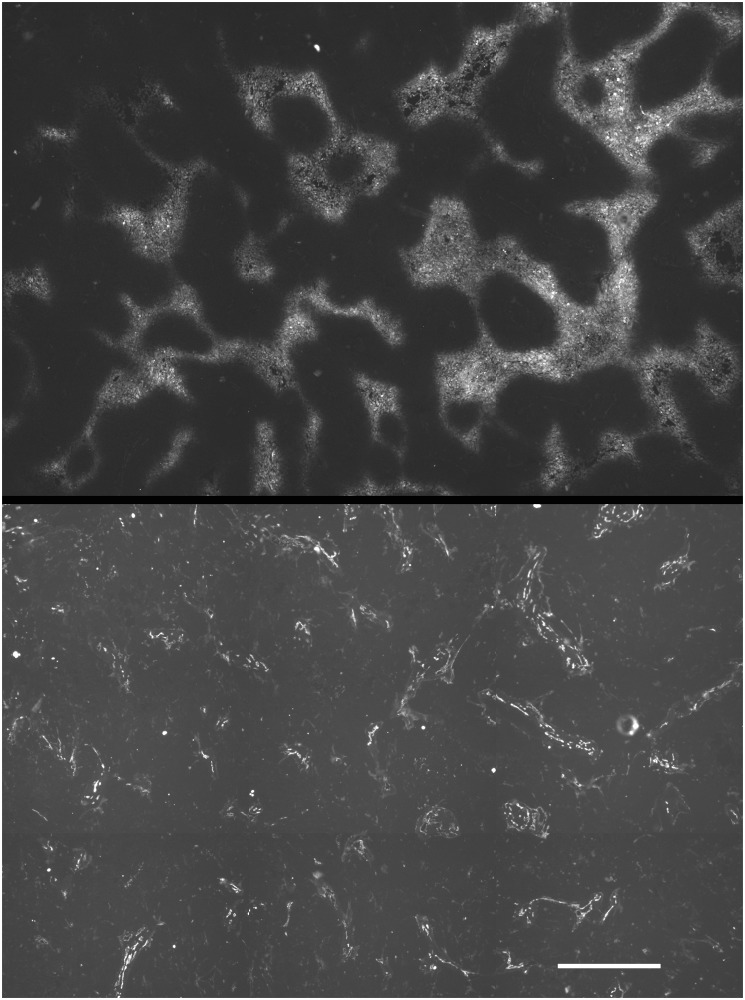
SQ20B tumors were hypoxic.SQ20B tumors contained EF5 binding (upper panel) which was inversely correlated with the position of blood vessels (lower panel). (scale bar 500 μm).